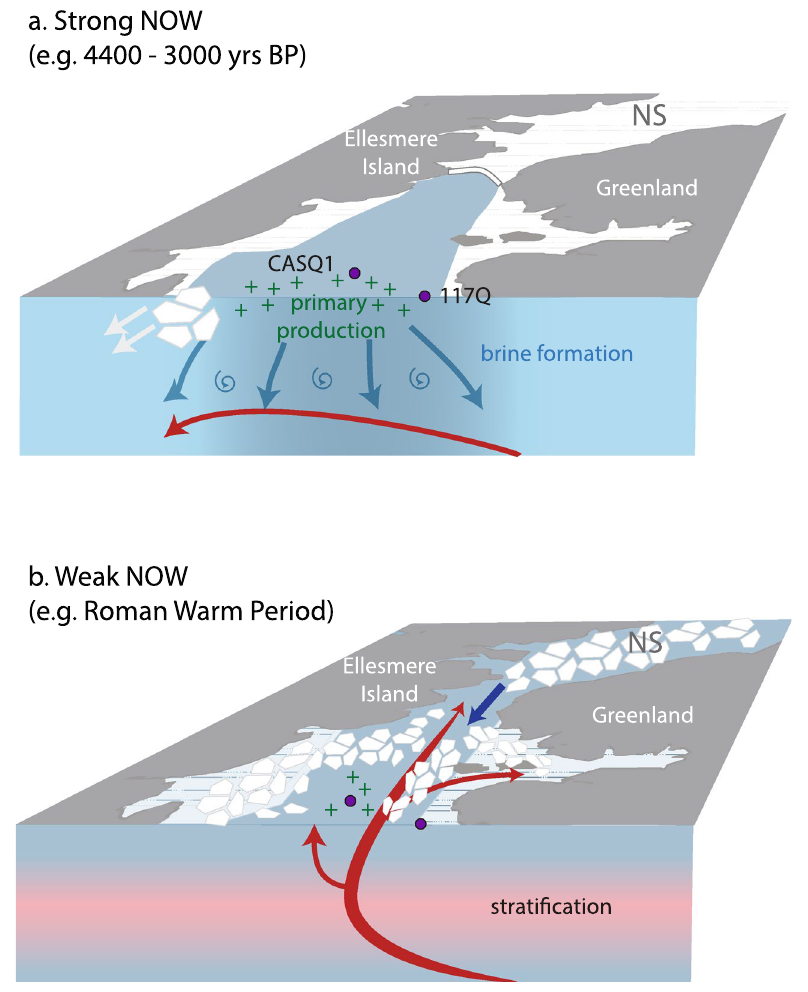
Figure 8. Schematic illustration of contrasting conditions and oceanic configuration in northernmost Baffin Bay/Nares Strait (NS). ( a ) Strong NOW and stable margin; a stable ice arch in Nares Strait facilitates productivity in the large open water area, allowing for the formation of PWW and mixing of brine enriched waters as a result of extensive sea-ice production and subsequent removal southward. This in turn ventilates the water column and diverts the flow of the WGC (red arrows) southward. ( b ) Weak NOW; ice arch instability allows for southward flow of Arctic sea-ice into the NOW region. Productivity is lower in the smaller open water region and weaker brine formation facilities northward penetration of WGC (AMW) into the region, prompting stratification. Purple circles indicate central and peripheral core